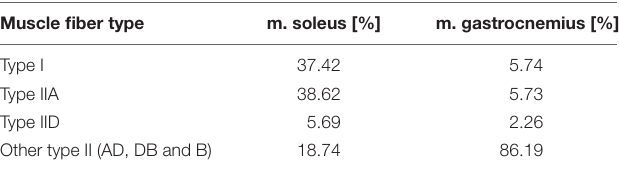
TABLE 1 | Percentage of muscle fiber types in the soleus and gastrocnemius muscle, modified according to Augusto et al. (2004).